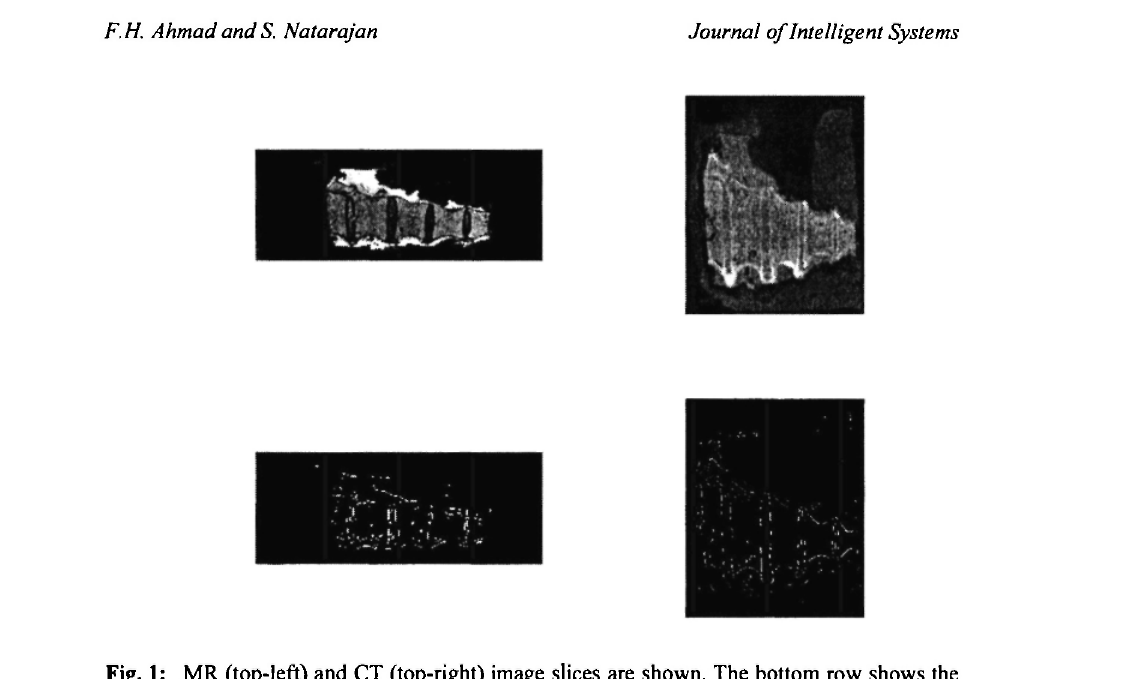
Fig. 1: MR (top-left) and CT (top-right) image slices are shown. The bottom row shows the crest lines obtained for MR (bottom-left) and CT (bottom-right) by using principal curvatures. The crestlines represent important features in both images.